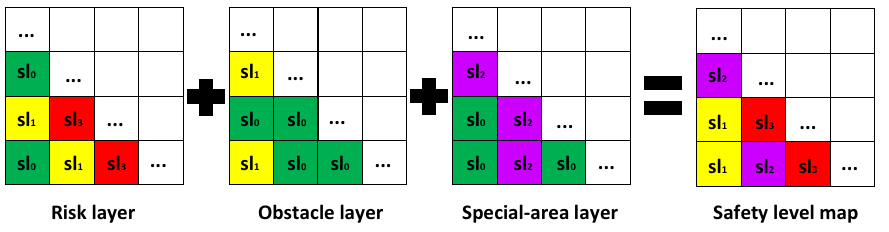
Figure 3. Procedure for layer combination.